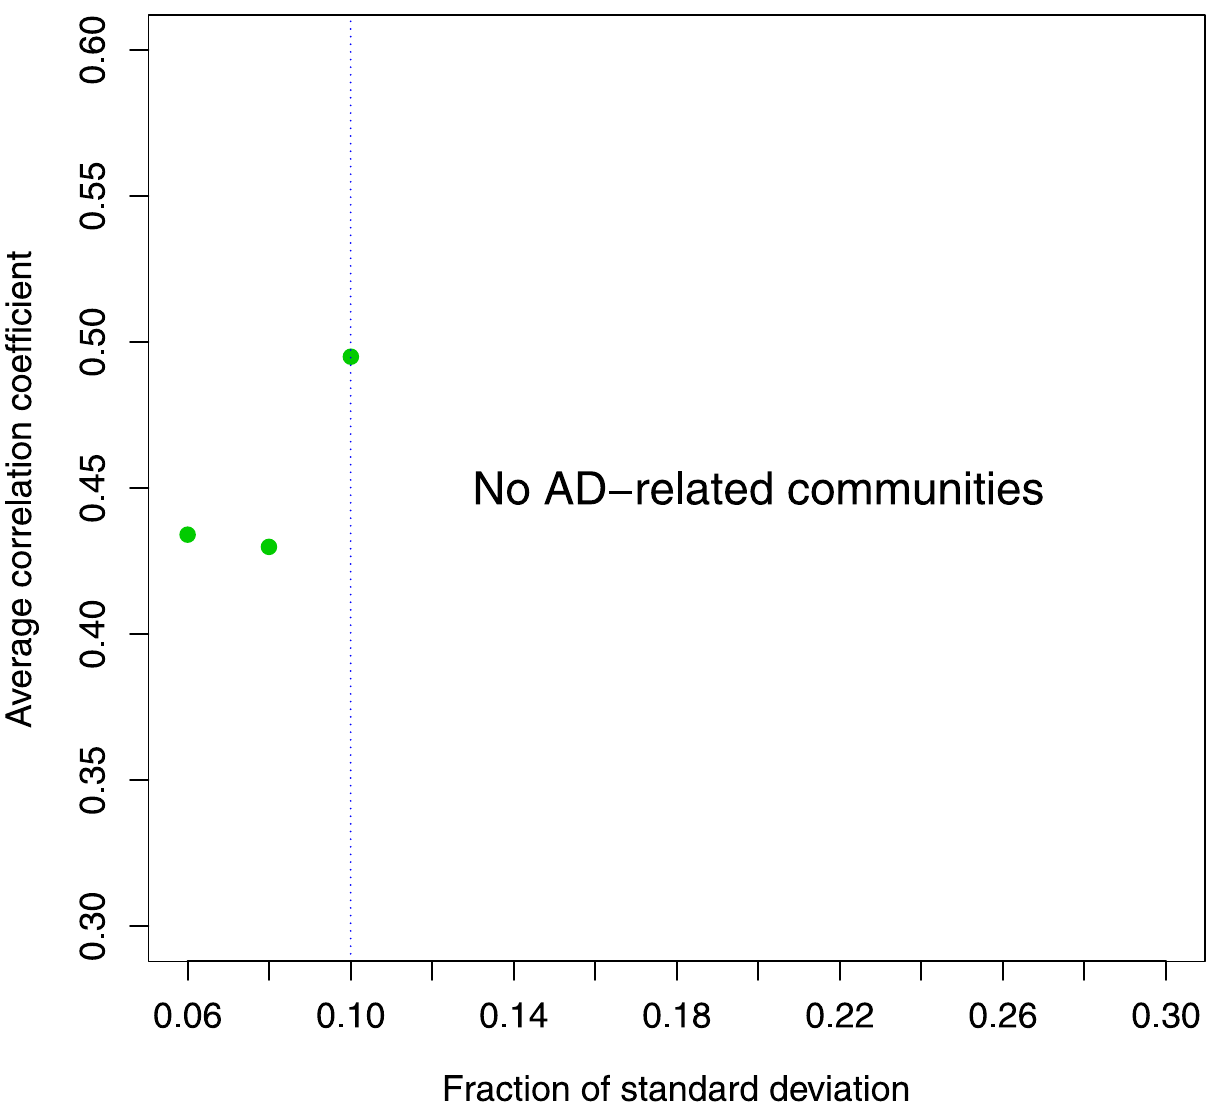
Fig 3. Average correlation coefficient with different cut. 0.1 σ of interest and clinical features MMSE and NFT. In fact selecting genes exceeding 0.1 σ